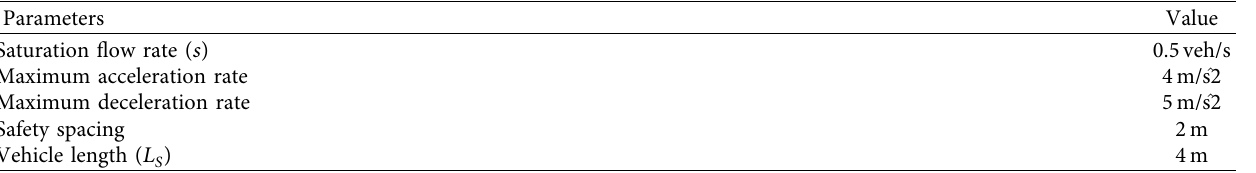
Table 1: Details of simulation parameters.